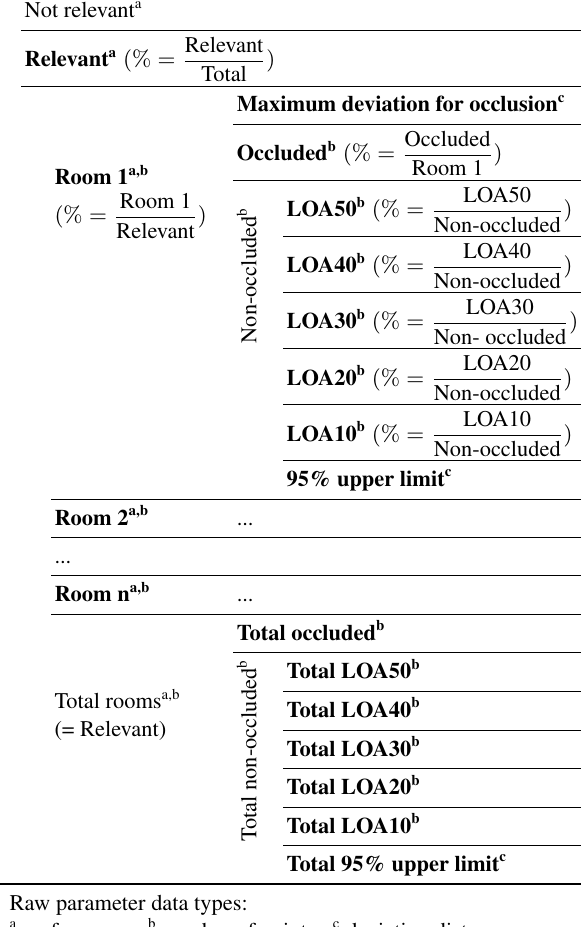
has parts in n rooms (including outside environment), given by equation